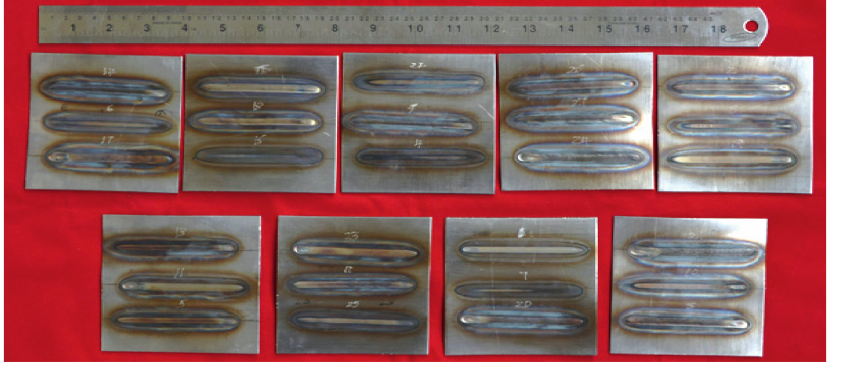
Figure 1: Plasma arc welded bead on plate welding of 2205 duplex stainless steel.